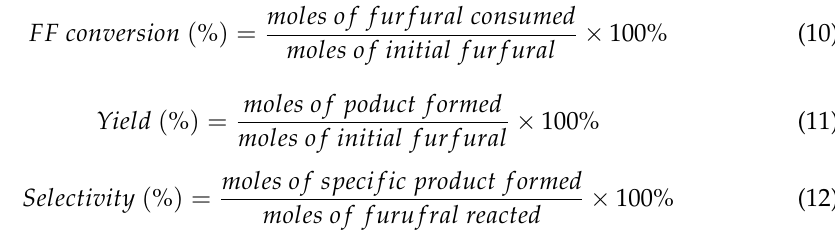
Figure S4: (a) HPLC spectra for Ni 0.85 Pd 0.15 collected after 0.5 hours of reaction. (b) HPLC spectra for Ni 0.85 Pd 0.15 collected after 0.5 hours of